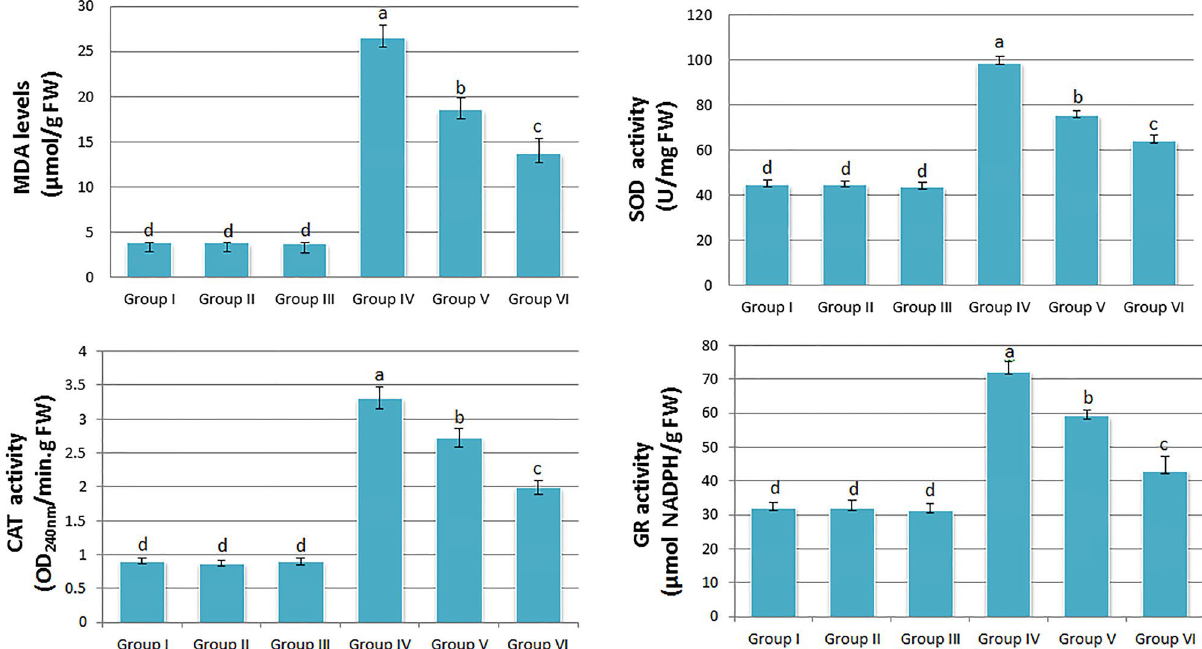
Figure 5. Effects of penoxsulam and BBE applications on lipid peroxidation and antioxidant enzyme activities ( a: MDA levels, b: SOD activity, c: CAT activity d : GR activity) [Group I: tap water (control), Group II: 25 mg/L BBE, Group III: 50 mg/L BBE, Group IV: 20 μg/L penoxsulam, Group V: 20 μg/L penoxsulam + 25 mg/L BBE, Group VI: 20 μg/L penoxsulam + 50 mg/L BBE. Data were shown as mean ± SEM. The averages shown with different letters in each graph are statistically significant (P <